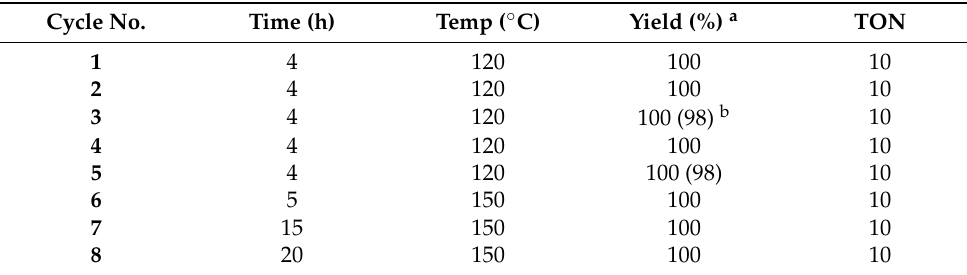
Table 7. Recycling results of 2a -catalyzed Stille reaction of 4-nitrobromobenzene ( 10 ) and vinyl tributyltin ( 3 ) under the thermomorphic mode.